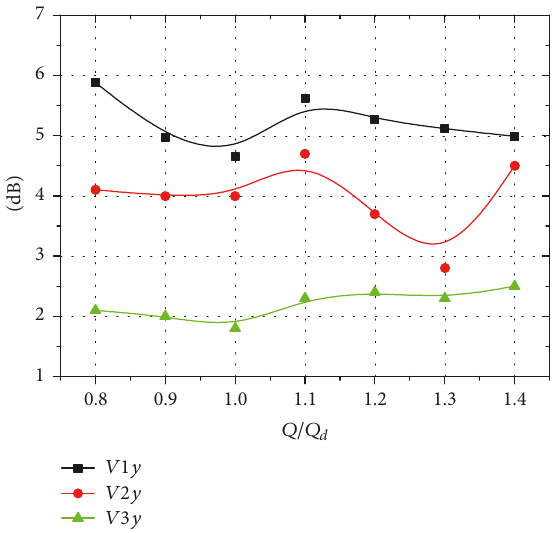
Figure 11: Increment of vibration energy from cavitation inception to full cavitation